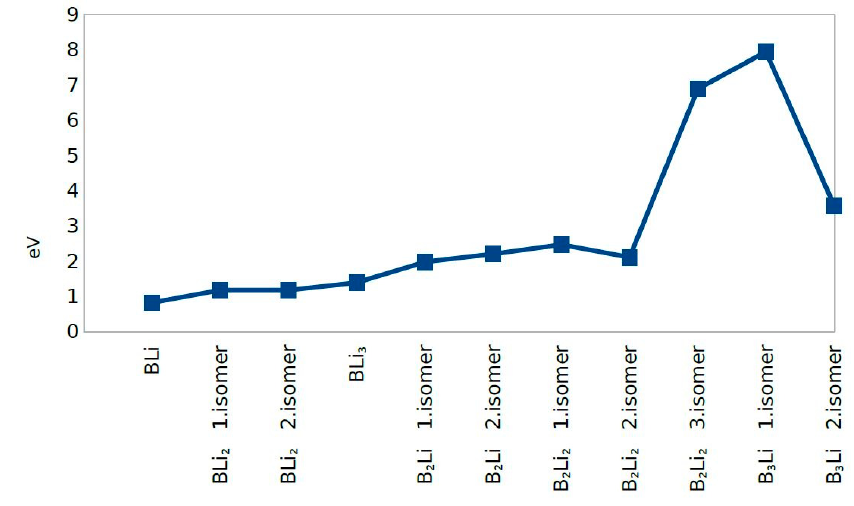
Figure 4. Force on Atom.